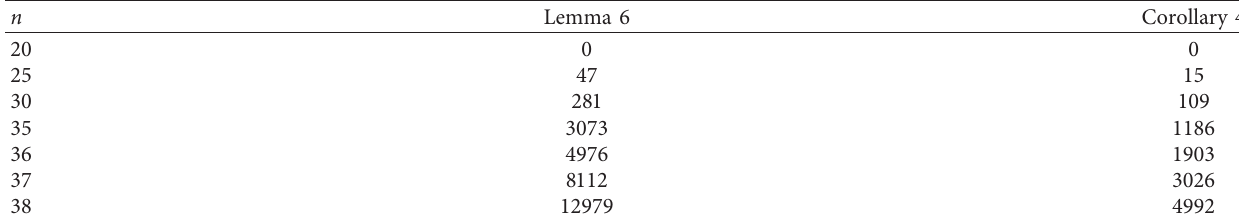
Table 2: Running time comparison of Lemma 6 and Corollary 4.